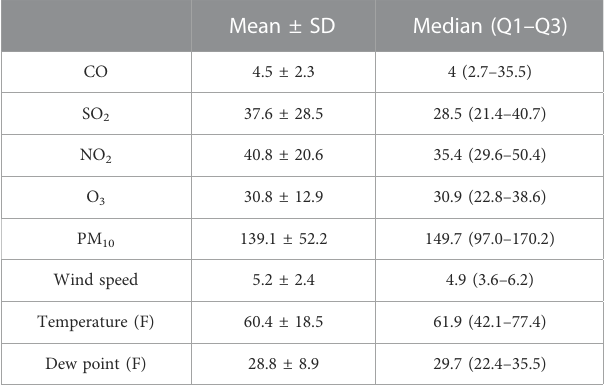
TABLE 2 Descriptive statistics for air pollution concentrations and weather